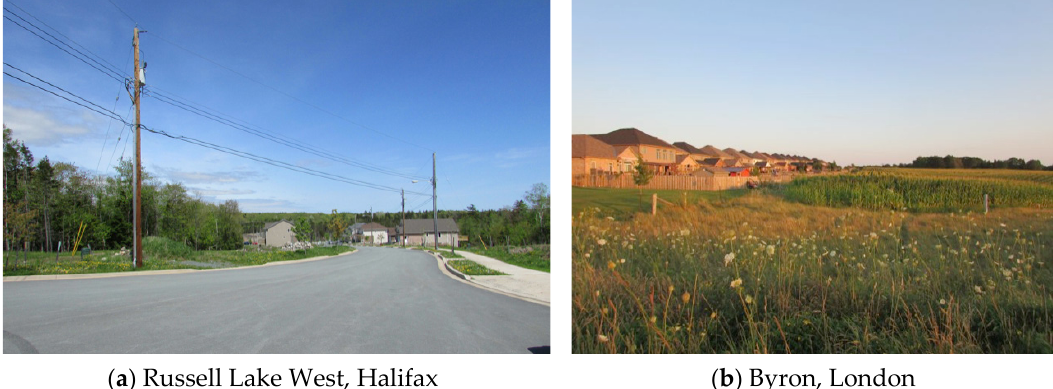
Figure 4. ( a ) An example of remnant woodland adjacent to a new subdivision development in Halifax; ( b ) An example of fields adjacent to a new subdivision development in London. Remnant stands in Halifax are generally found between property lines behind and beside housing developments as well as along pedestrian footpaths. In London, the scattered forest corridors that remain often exist further away from the